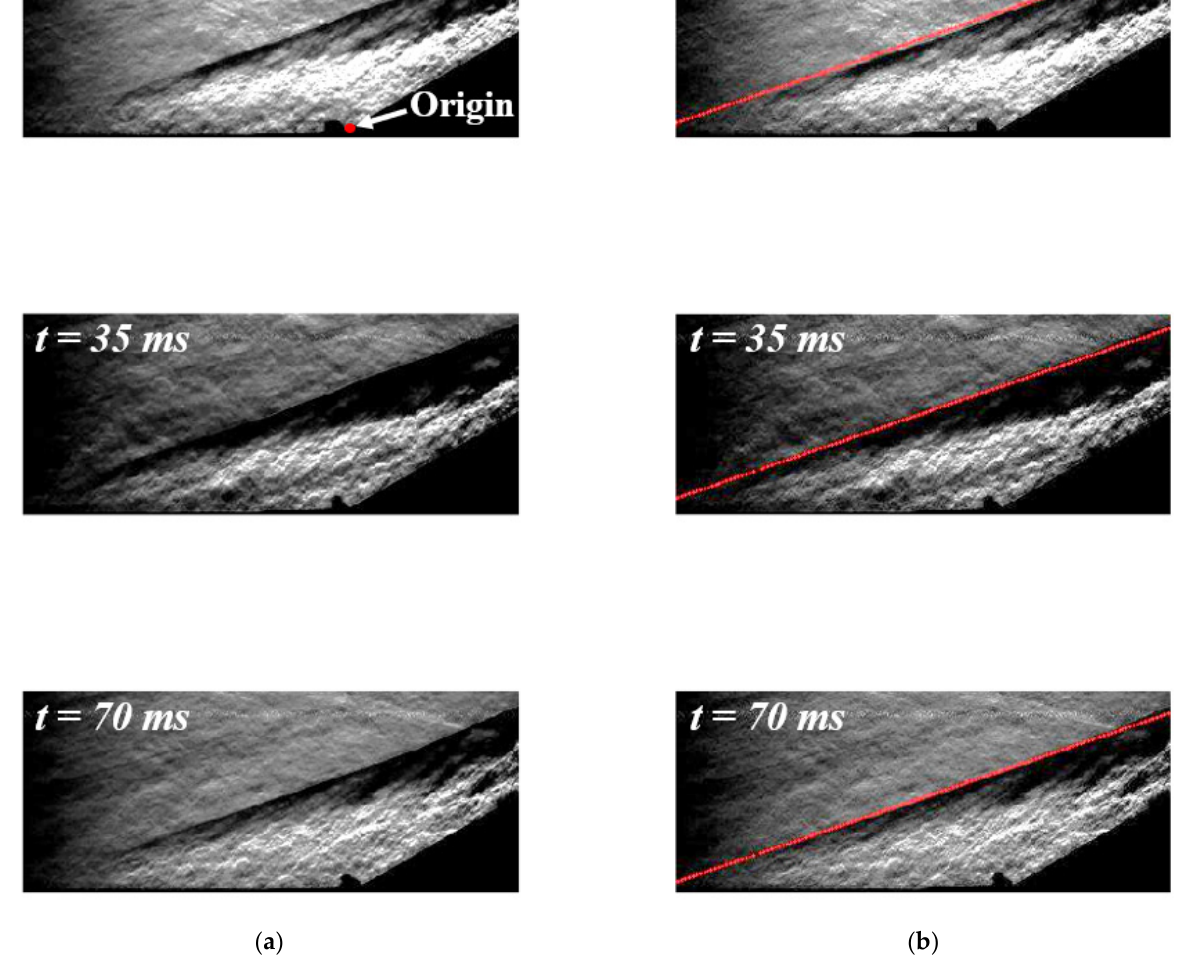
Figure 3. Representative schlieren images demonstrating computed shock positions of rough surface, ( a ) instantaneous images, and ( b ) corresponding shock tracking